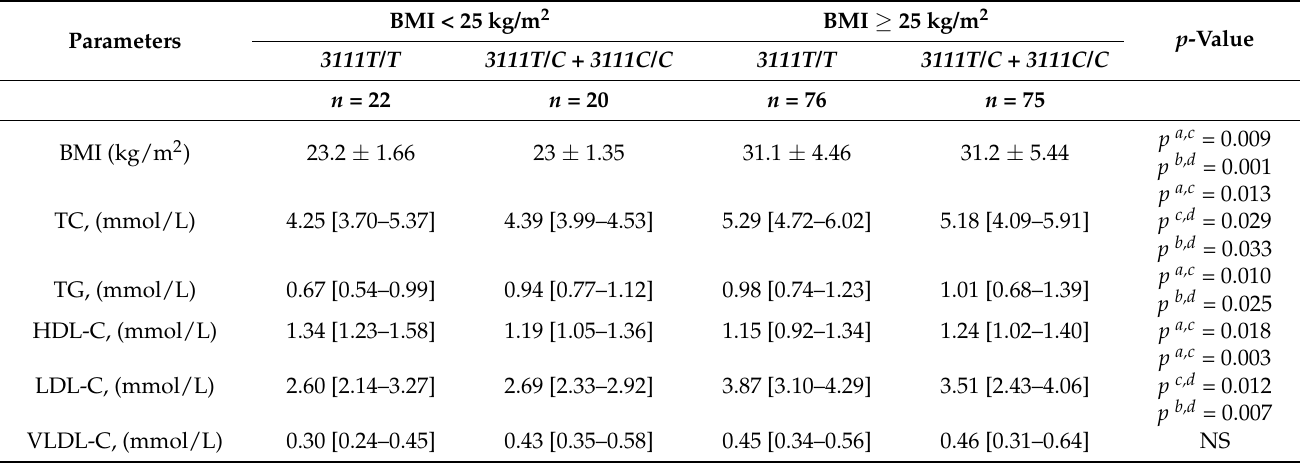
Table 4. BMI and lipid profile parameters in women who are carriers of different CLOCK 3111T/C gene polymorphisms ( rs 1801260